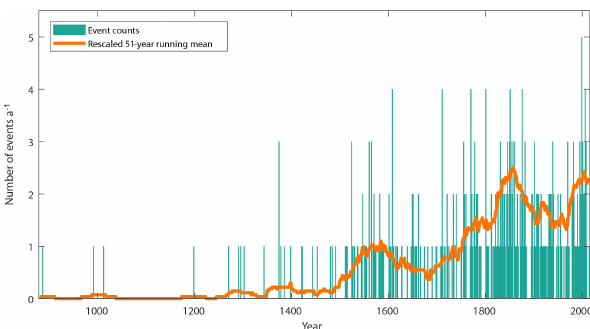
Figure 9. Chronology of all recorded events: annual distribution and smooth underlying